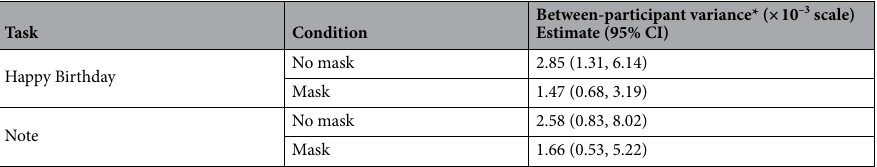
Table 2. Variance in droplet production between participants when singing a note and ‘Happy Birthday’. *Obtained from multilevel negative binomial regression analyses.